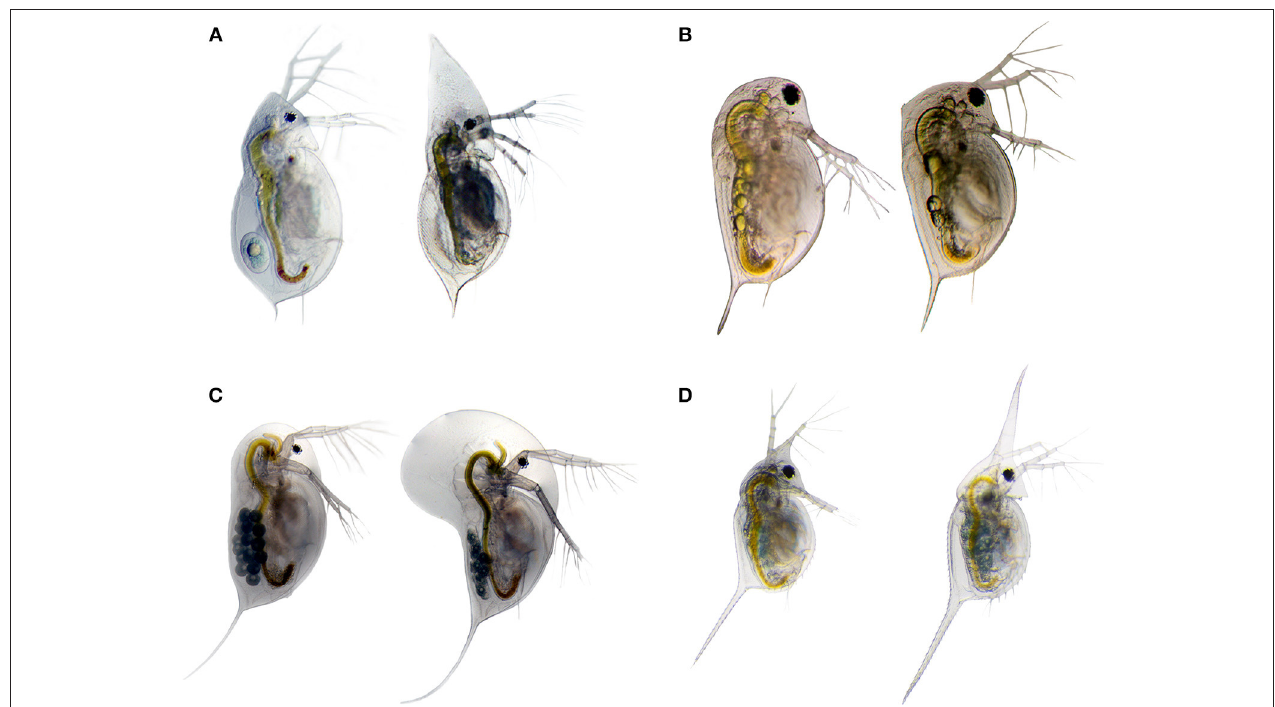
FIGURE 3 | Inducible morphological defenses are manifold in the genus Daphnia . The listed examples show helmet expression in D. cucullata (A) ; crest expression in D. longicephala (C) ; head- and tail-spine formation D. lumholtzi (D) , and neckteeth expression in D. pulex (B) . Undefended morphotypes are displayed on the left side, and the defended morphotype on the right side. Images by Becker &